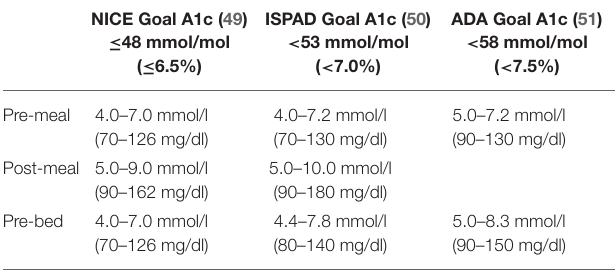
TABLE 1 | PROs incorporated into the 4T program. Topic Construct measured/relevant points Youth and parent outcomes—diabetes distress Diabetes distress (Diabetes Distress